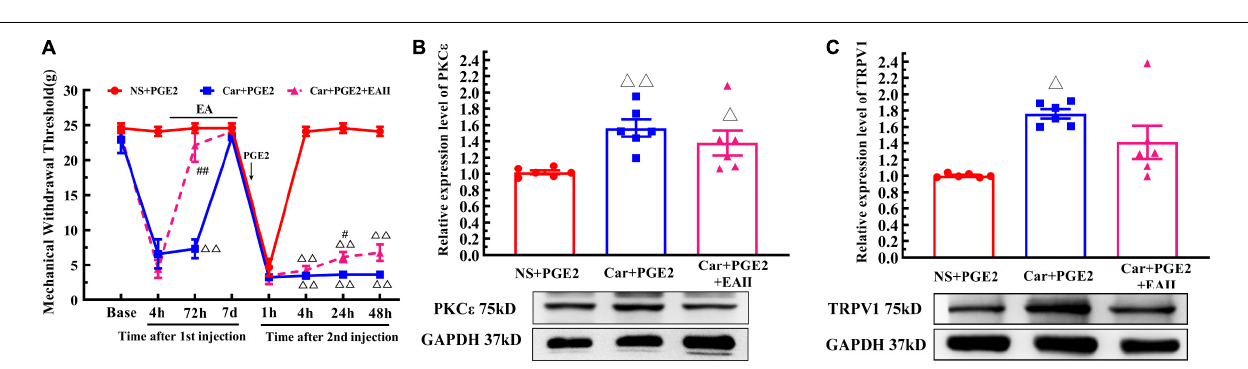
FIGURE 9 | Electroacupuncture (EA) partly prevented the transition from acute to chronic pain. Mechanical (A) responses of hyperalgesia model animals to EA administration only after the first injection. n = 6. The quantification of the Western blot results and a representative Western blot showing PKC ε (B) and TRPV1 (C) protein isolated from the DRG 48 h after PGE2 injection. (cid:52) , (cid:52)(cid:52) Compared with the NS+PGE2 group, P < 0.05, P < 0.01; # , ## Compared with the Car+PGE2 group, P < 0.05, P <